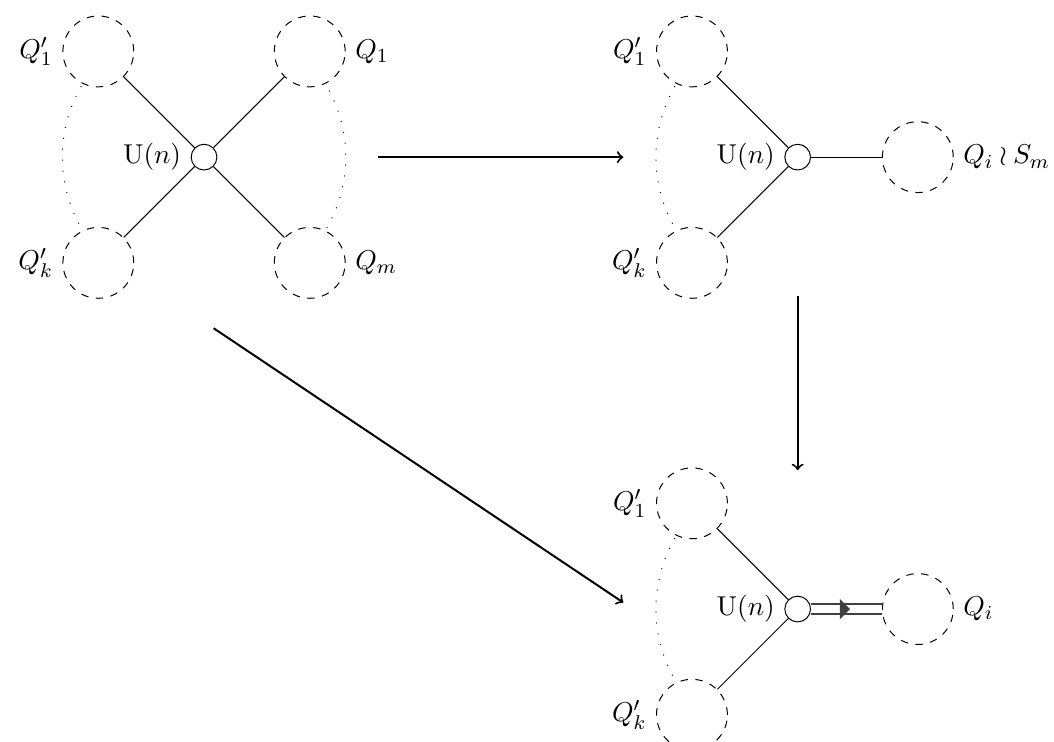
Figure 1 . (Top left) k generic subquivers Q 0 Q m are connected to a common central U( n ) node. (Top right) Wreathed quiver. (Bottom right) Non-simply laced quiver. The multiple link has valence m , here depicted for m = 2